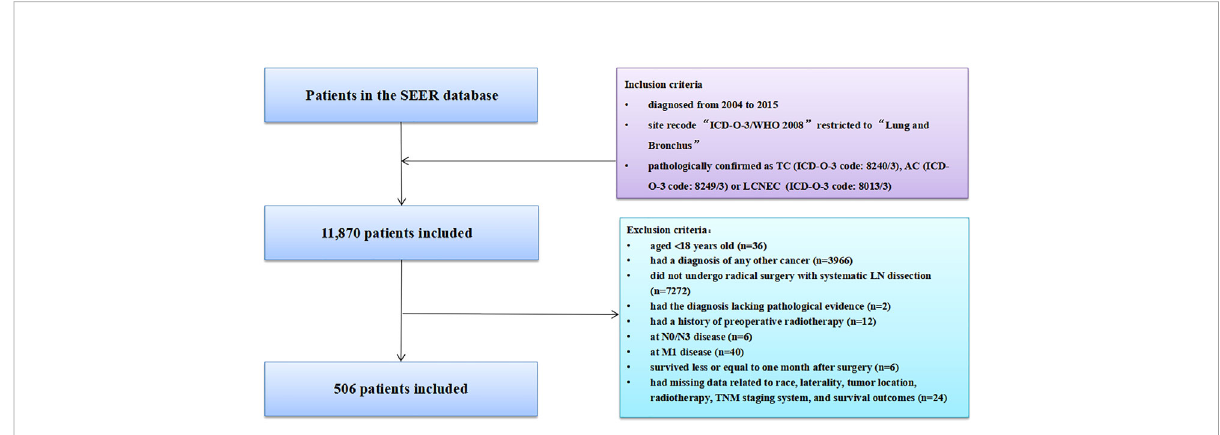
FIGURE 1 Selection of study cohort from the SEER database. AC, atypical carcinoid; LCNEC, large cell neuroendocrine carcinoma; SCLC, small cell lung carcinoma; SEER, Surveillance, Epidemiology, and End Results; LN, lymph node; TNM,